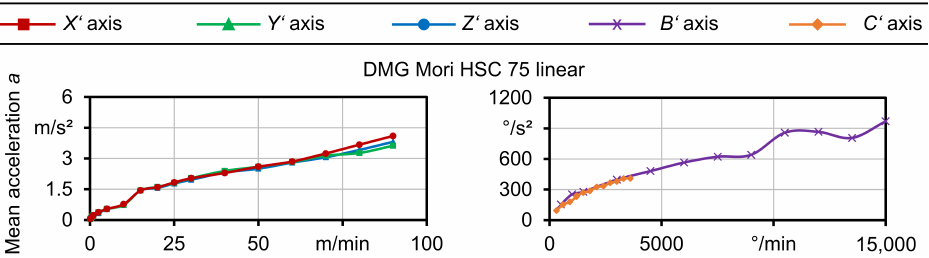
Figure 5. Modelling of the acceleration by the measured mean acceleration a as a function of the feed rate difference between the current and former NC step for the machine tool DMG Mori HSC 75